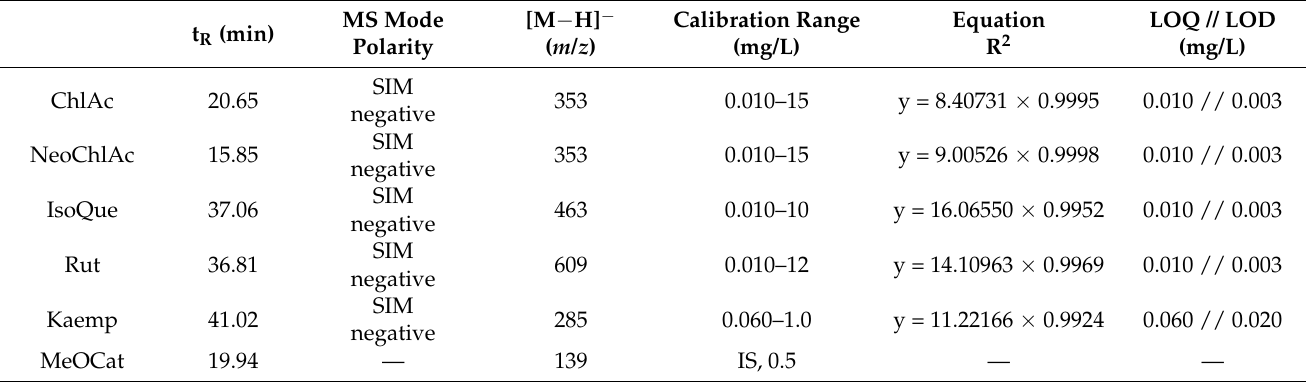
As an example, typical equations and R 2 values, relevant to the calibration carried out for a set of measurements, are also reported. Hydroxycinnamic acid derivatives and isoquercetin derivatives were quantified as chlorogenic acid equivalent and isoquercetin equiva- lent,